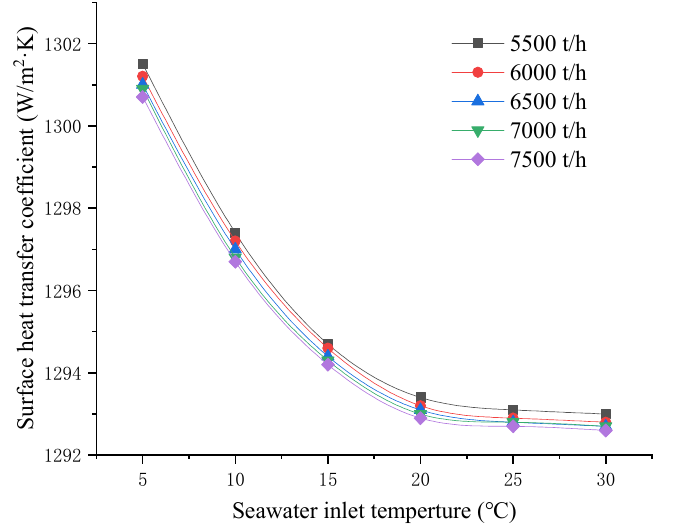
Figure 11. Surface heat transfer coefficient on the tube side at different seawater mass flow rates and temperatures in the NG heater.